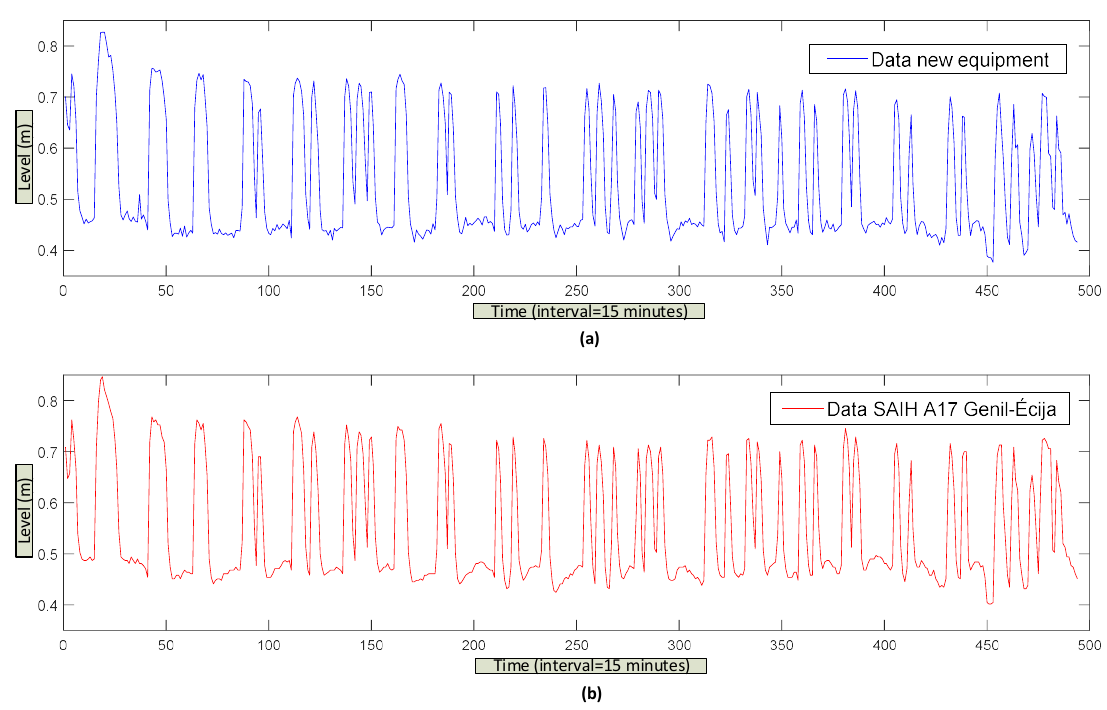
Figure 11. Data obtained (every 15 mins from the A17 Genil-Écija control point), ( a ) with the equipment developed and ( b ) with those from the SAIH of the Guadalquivir river.